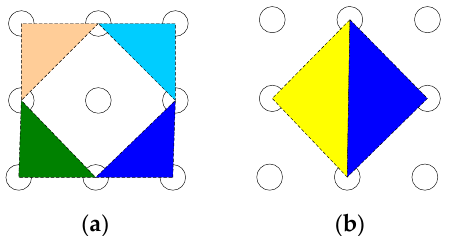
Figure 5. Basic projection operator diagram. ( a ) Diagonal tangent planes; ( b ) minimum triangular tangent planes.